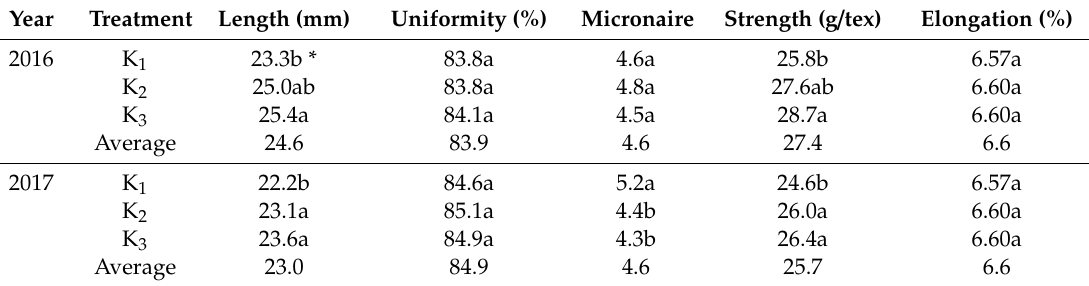
Table 4. Cotton fiber quality influenced by K fertilizer